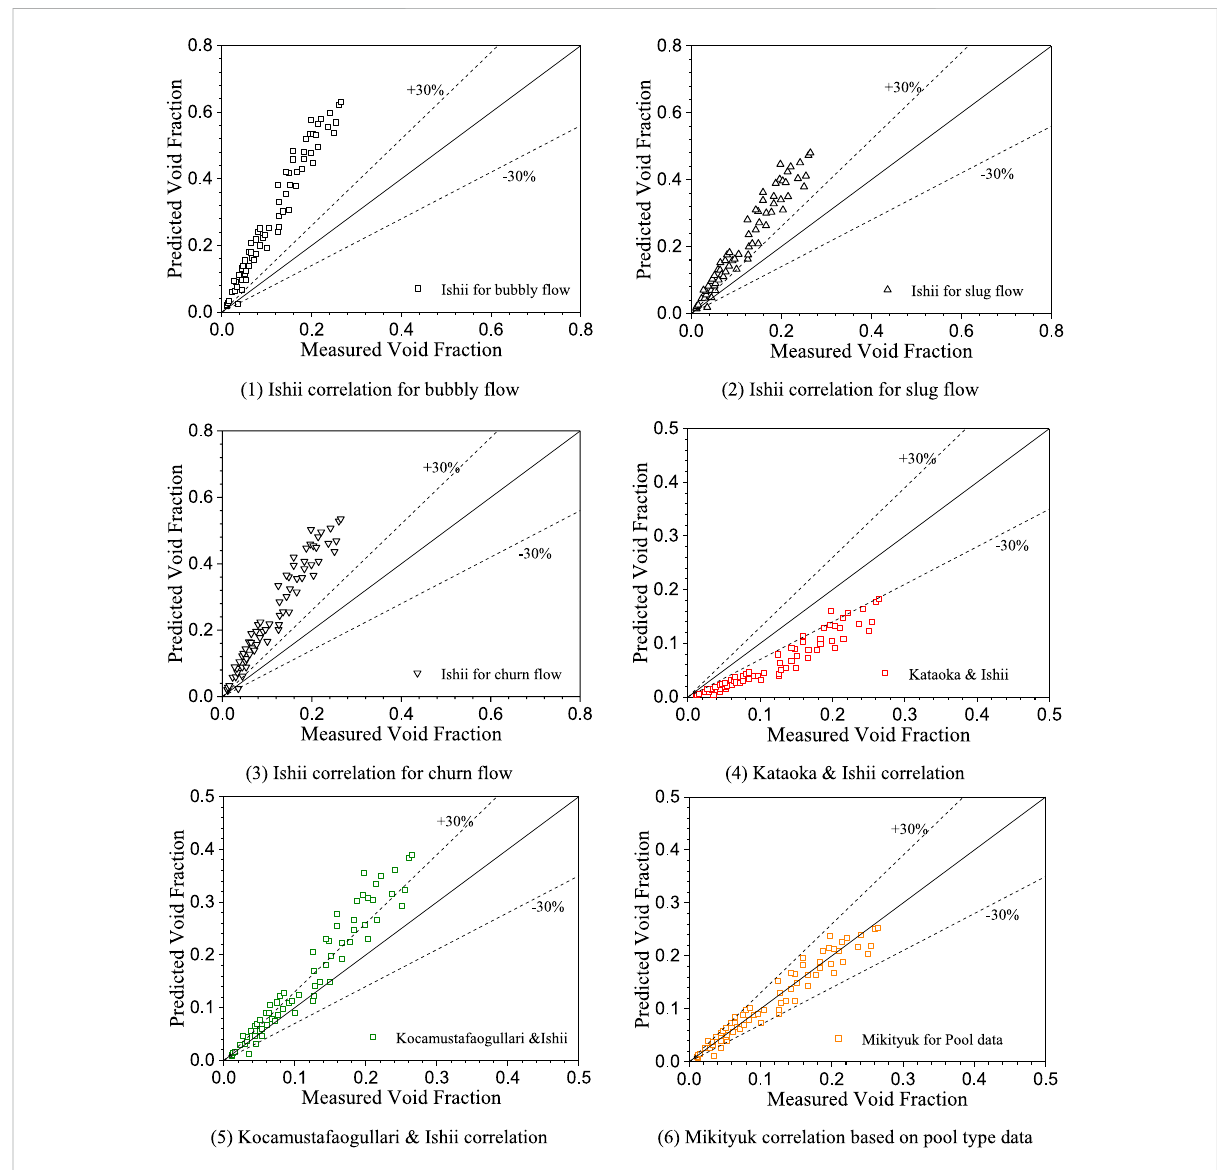
2003), due to the high density ratio between phases. A comparison between the prediction of Kocamustafaogullari and Ishii correlation and test data is shown in Figure 4E. The result indicates that in the range of 0 – 0.05, the correlation underpredicts the void fraction. As the void fraction increases, the overestimation is about 30%, which is less than that by Ishii correlations for different fl ow